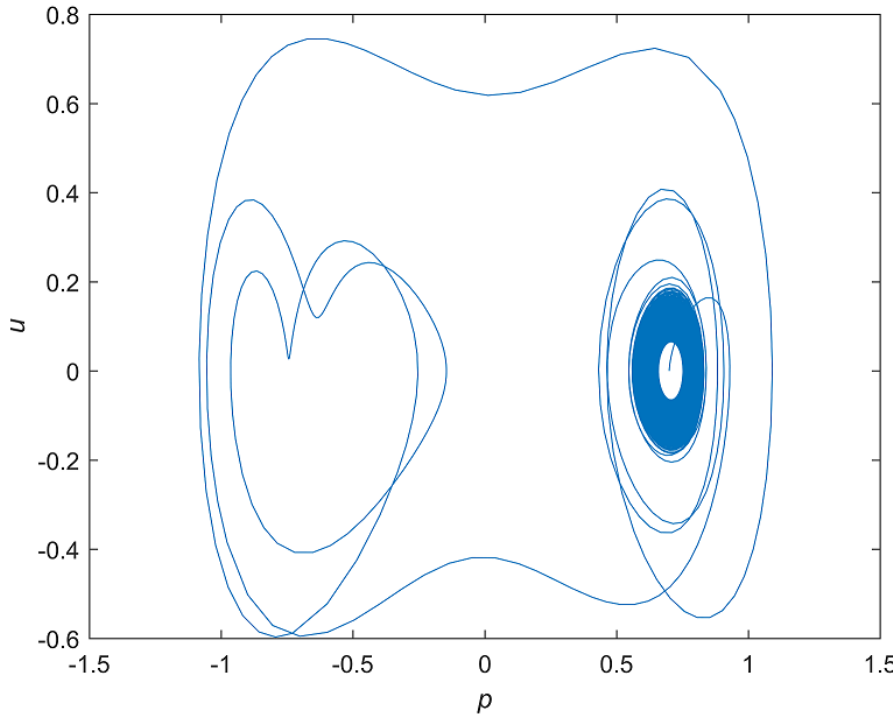
Figure 1. The phase diagram in the p - u plane.